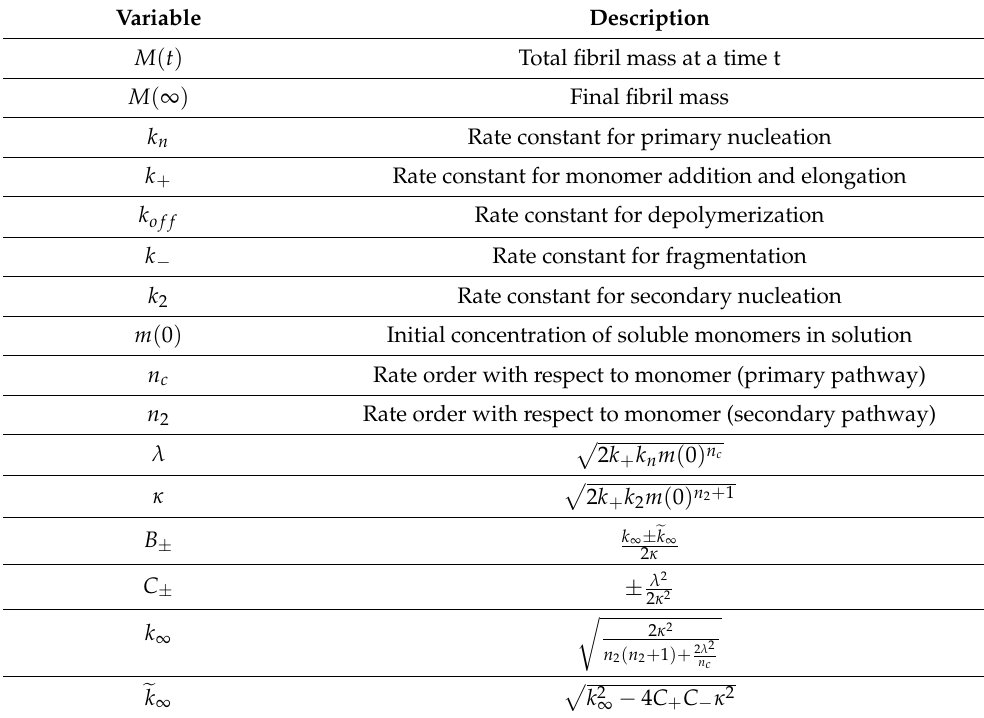
Figure 9. Sigmoidal kinetic curve for amyloid formation probed by using ThT fluorescence. Thioflavin T bound to polymeric amyloid fibrils and increase in fluorescence intensity signaled increased formation of amyloid fibrils. The nascent unfolded polypeptide may either drop down into a native folding cascade via partially folded intermediates (1) and/or may directly be recruited in nucleus formation (3). The native monomer similarly can either undergo partial unfolding (2) and/or associate with the forming nucleus (4,5). When concentration of amyloid fibrils increases significantly, the secondary processes (6) take over as the dominant. For a description of the variables and parameters used please refer to Table 1. Table 1. Variable description for Amyloid Kinetics Rate Law by Cohen et al. [227–229].